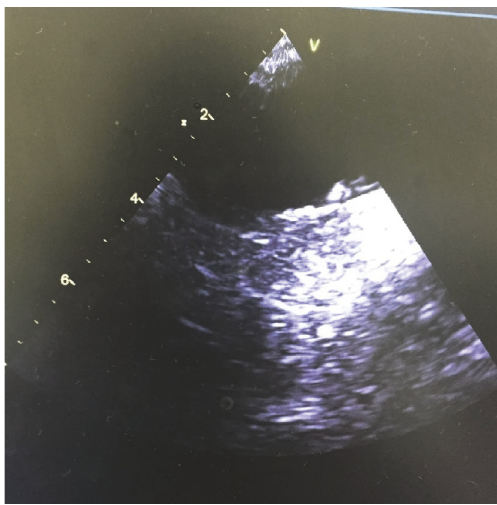
Figure 4: Follow-up TEE performed four months later demonstrating that prior echogenic mass in the aortic arch had decreased in size. Abbreviation. TEE: transesophageal